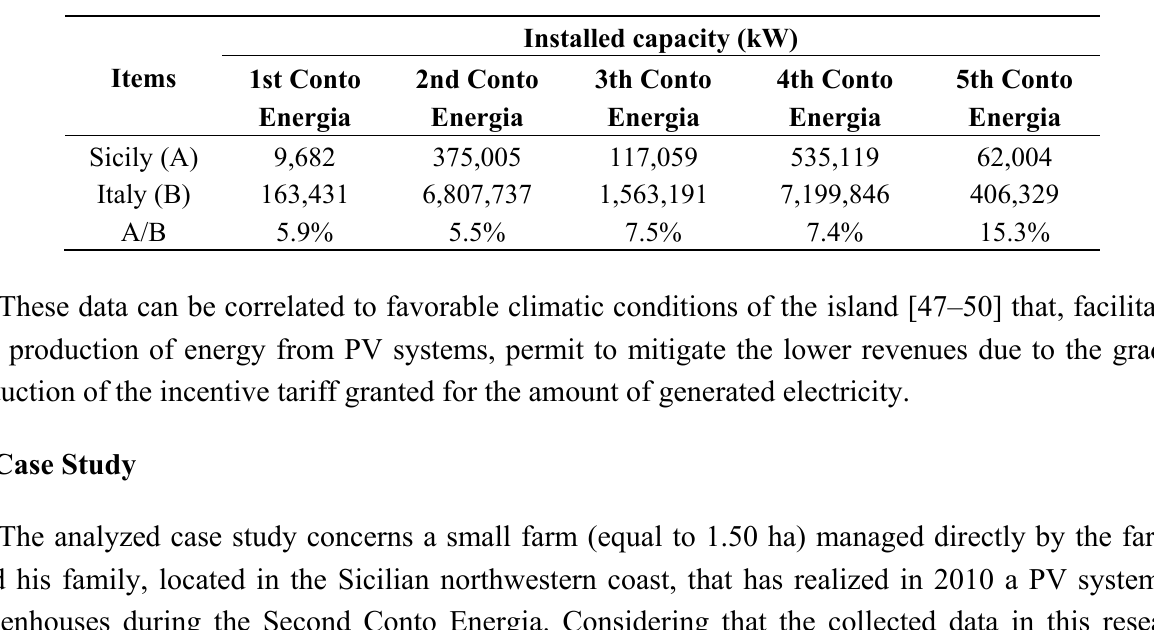
Table 2. Sicilian incidence of PV installed